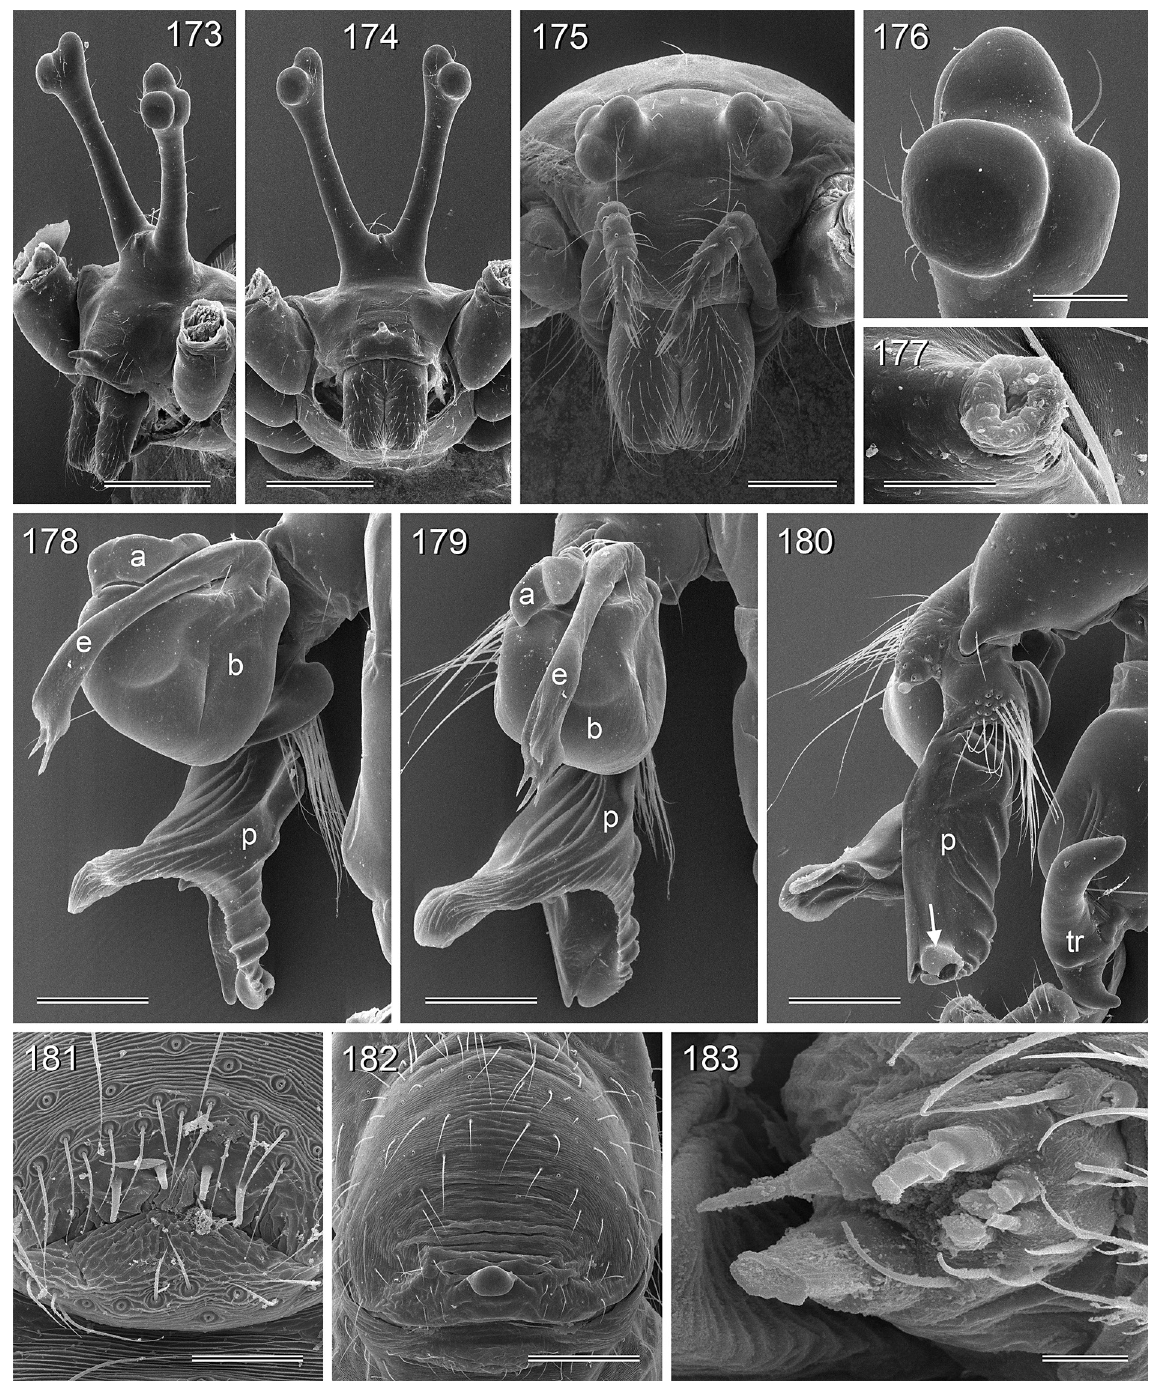
Figs 173–183. Pholcus schwendingeri Huber, 2011, ZFMK Ar 15051–52. 173–174 . Male prosoma, oblique and frontal views. 175 . Female prosoma, frontal view. 176 . Male eye triad. 177 . Process between male eye stalks. 178–179 . Right genital bulb and procursus, prolateral and dorsal views. 180 . Left palp, retrolateral view (arrow points at whitish membranous structure). 181 . Male gonopore. 182 . Epigynum, ventral view. 183 . Female ALS. Abbreviations: a = appendix; b = genital bulb; e = embolus; p = procursus; tr = trochanter. Scale lines: 10 µm (183); 20 µm (177); 50 µm (181); 80 µm (176); 200 µm (175, 178– 180, 182); 400 µm